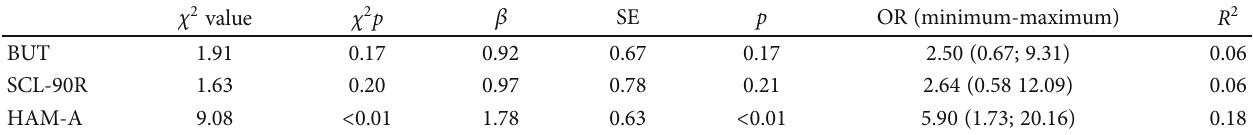
Table 4: IL-1 β A carrier risk for depression, dysmorphic, and anxiety symptoms.